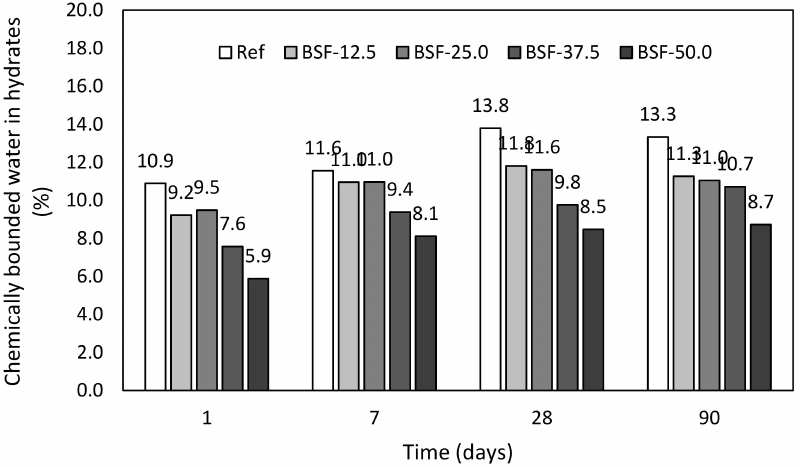
Figure 5. Chemically bounded water in hydrates—pastes with blast furnace slag.